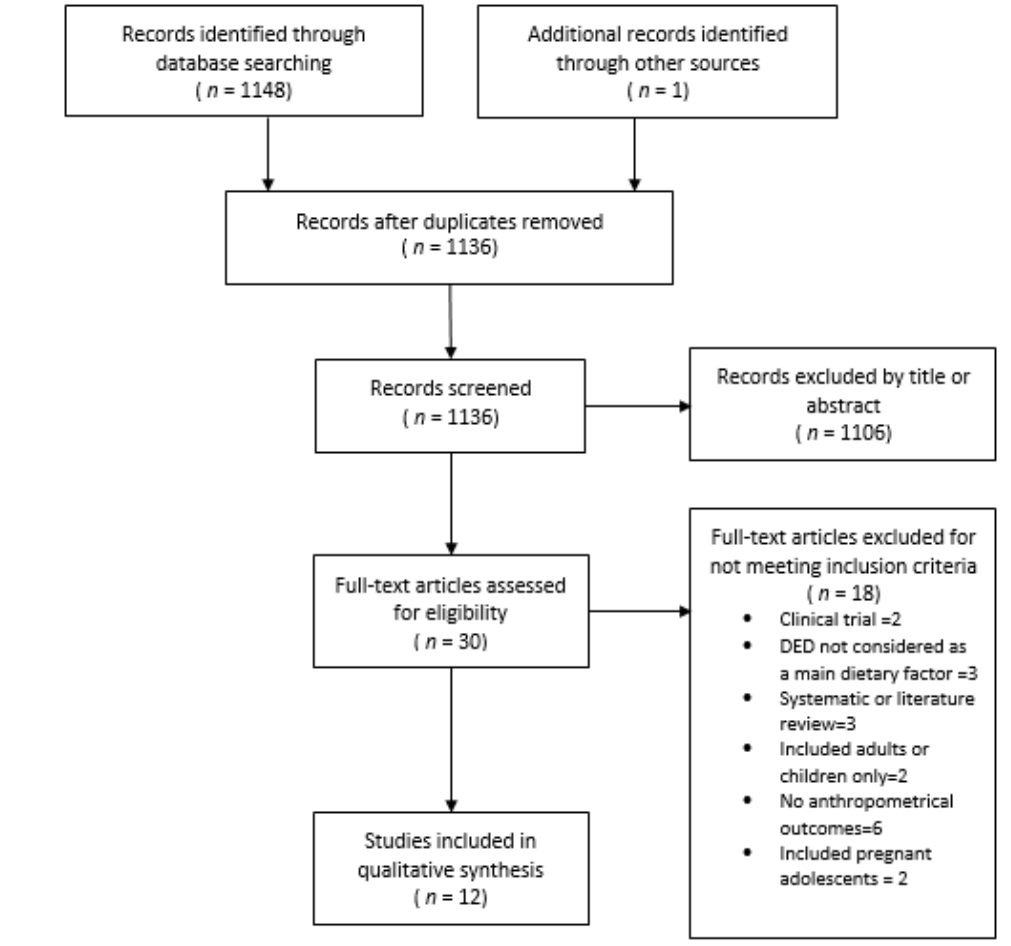
Figure 1. Flow chart illustrating the study selection process.